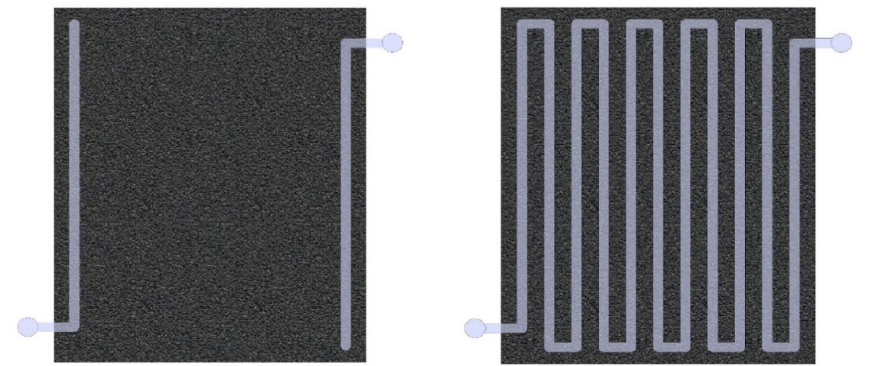
Figure 3. Type of flow half-cells of various designs.